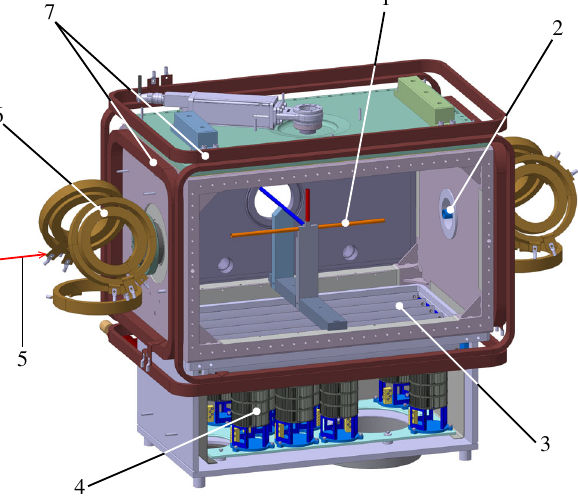
FIG. 6. Section view of the PAX target chamber. The labels denote the storage cell (1) with feeding tube to the ABS (vertical), and extraction tube to the BRP (to the backside), flow limiters (2) of 19 mm diameter and 80 mm length, jalousie (3) to protect the cell from heat radiation during activation of the nonevaporable getter (NEG) pumps (4), COSY beam (5), guide field compen- sation coils (6), and magnetic guide field coils (7).